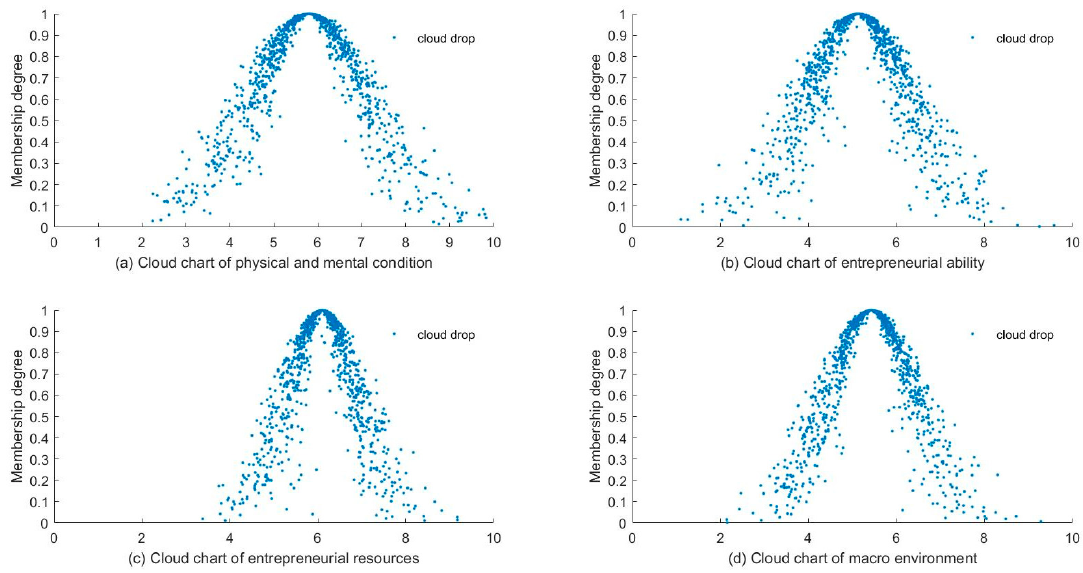
Figure 3. The CM of the primary level indexes of 1# entrepreneur.